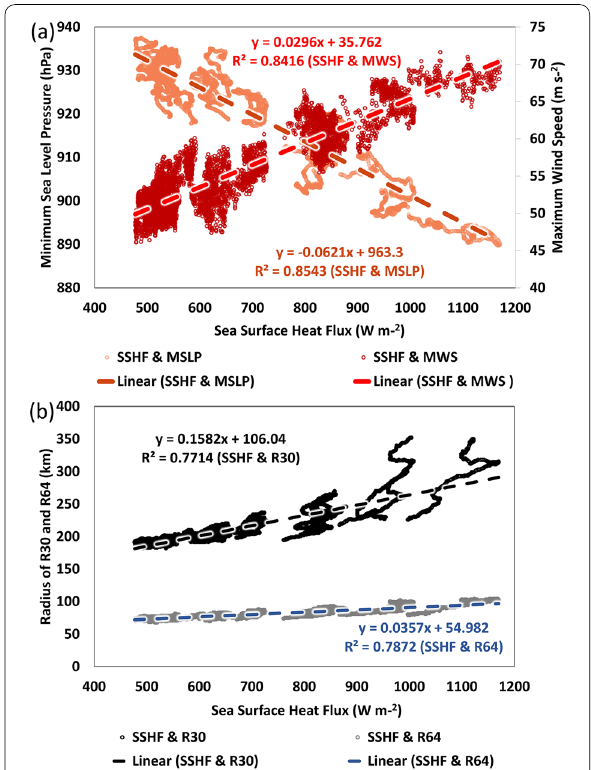
Fig. 13 Scatter‑plot diagrams of the subsequent 96–144 h SSHF against a MSLP and MWS, b R30 and R64. The dashed lines are the best‑fit lines. The R 2 from the regression equation and percentage variance is also listed among the TC intensity and size